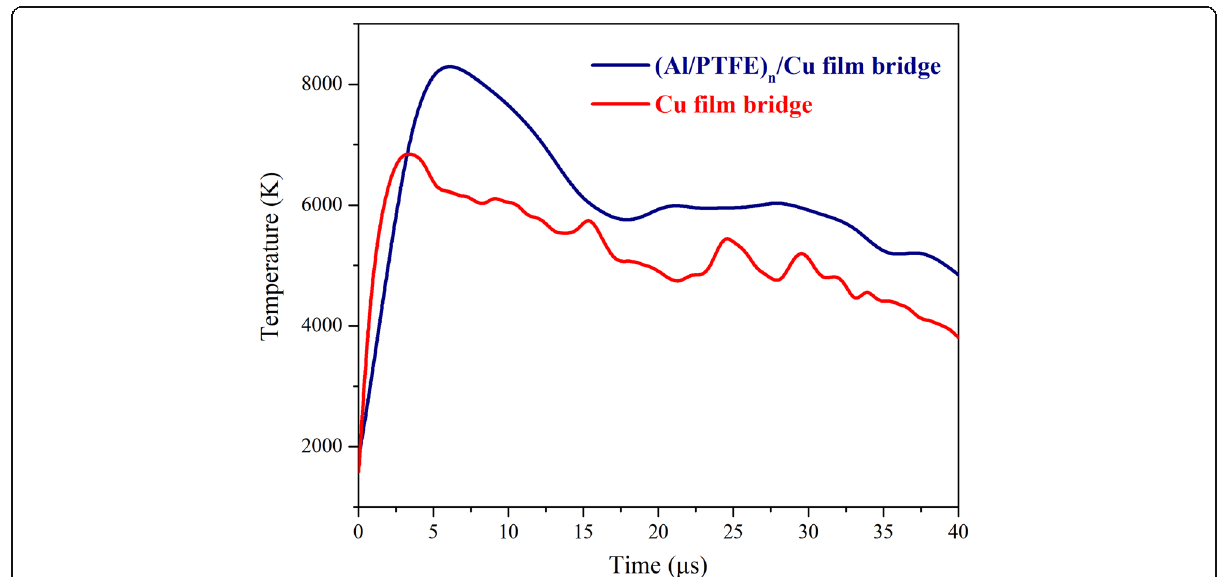
Fig. 6 The temperature variation curves after data processing during the electric explosion process for the Cu film bridge and the (Al/PTFE) n /Cu film bridge at a 2500-V discharge voltage